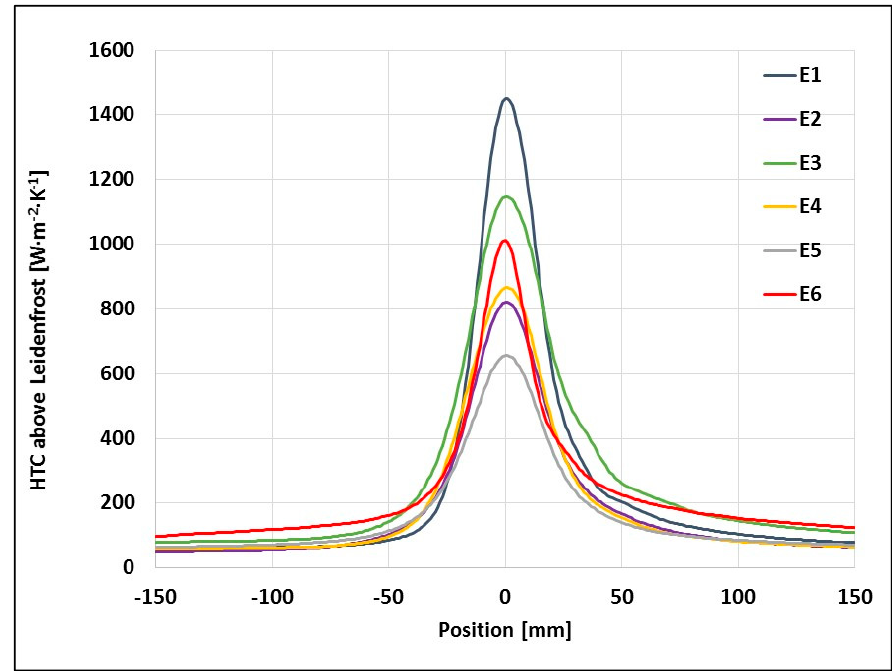
Figure 5. HTC averaged from runs above the Leidenfrost temperature for thermocouple “A” (y = 0